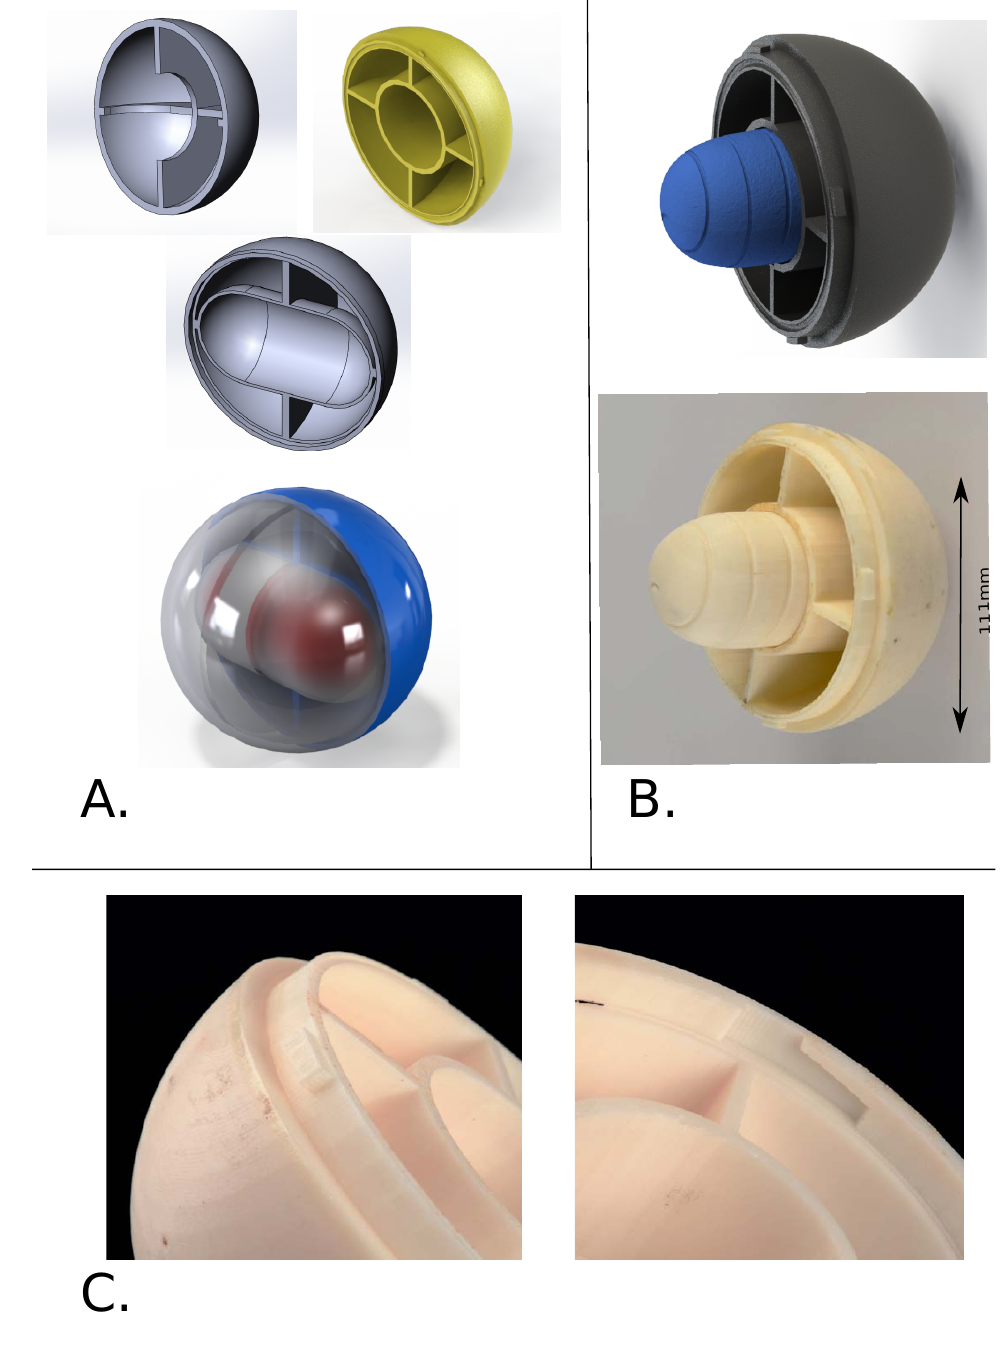
at 1:1 scale for demonstration (Figure 4B) and the constructed case based on this pebble (Figure 4B,C) were designed using the same input. Figure 4 also shows a scaled representation for Pebble B. Figure 3. Spherical outer case: ( A ) Designs for the internal structure of the outer case. The case can be designed to enhance durability (support structures), water-proof performance (O-rings) and density control (voids); ( B ) Incorporation of the internal case for the G-node (design and photograph); ( C ) Demonstration of the locking system to make the overall assembly rigid, but not impossible to